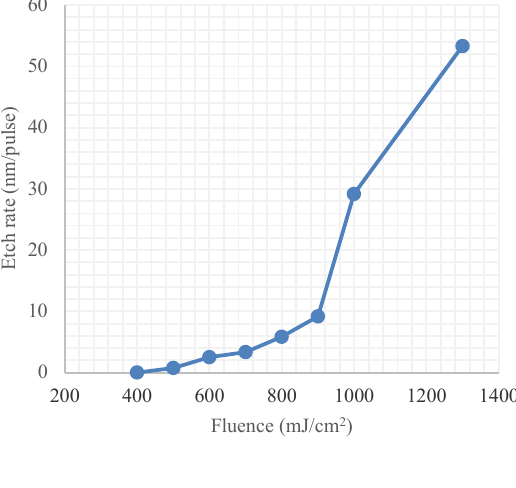
Fig. 3 Etch rates per laser pulse. Fig. 4 Linear relation between depth and number of passes for